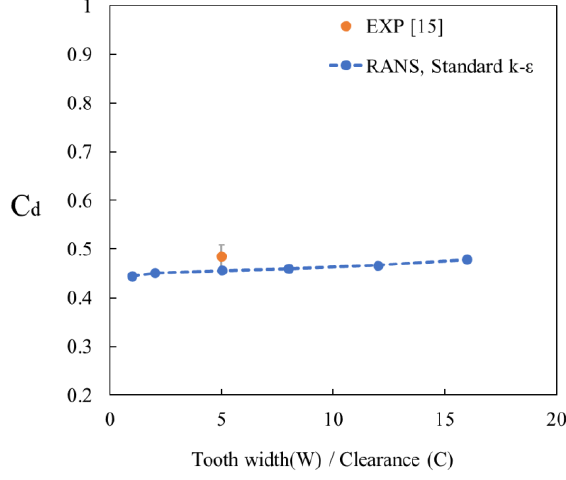
Figure 16. The effect of varying the tooth width to clearance (W/C) ratio on the streamlines of a straight‐through labyrinth seal under a pressure ratio of 2 when the whole axial length was fixed.